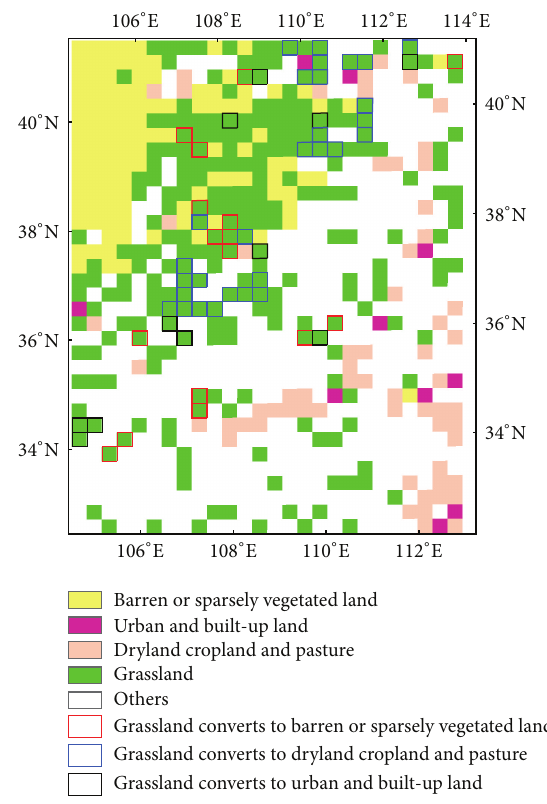
Figure 2: Conversion from grassland to other land use types between 2010 and 2040 of the overgrazing areas in Northwest